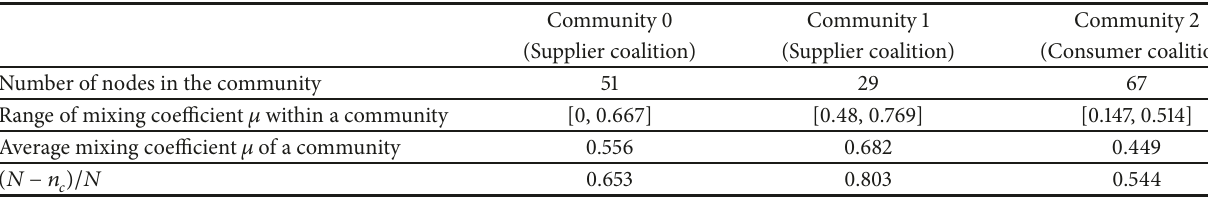
Table 6: Mixing parameters in detected communities in the no network.